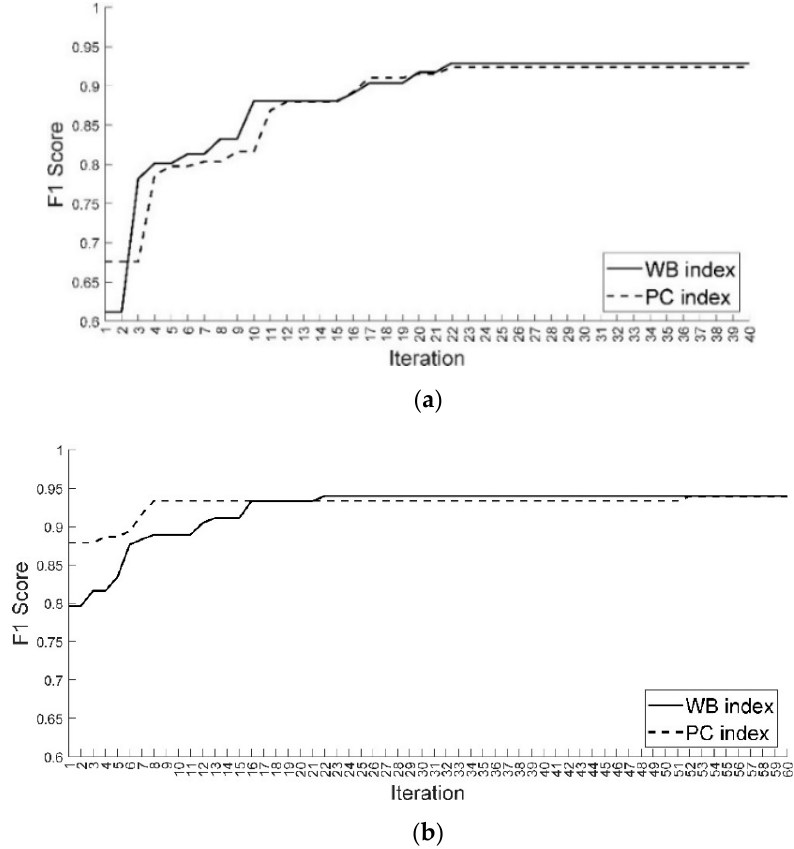
Figure 5. Feature selection performance results for terrain ( a ) and slippage ( b ) classifier.